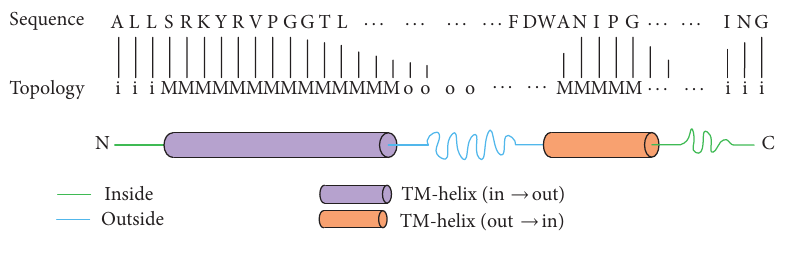
F 1: Topology prediction of transmembrane